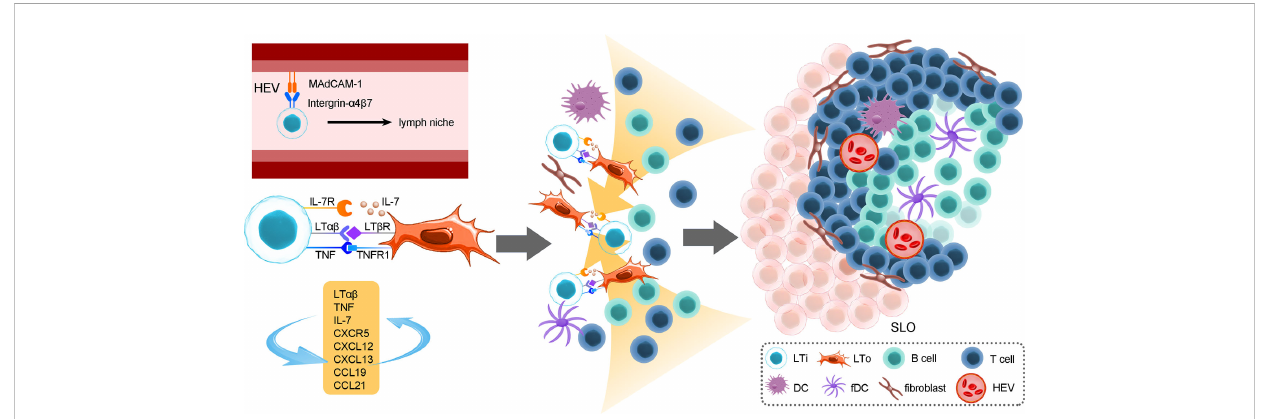
FIGURE 2 The roles of LTi cells in the development of secondary lymphoid organs. The formation of SLOs in the mouse intestine strictly depends on LTi cells. SLO development is highly reliant on the crosstalk between LTi cells and LTo cells and consequently immune cell recruitment, reticular scaffold formation and HEV or lymphoid vessel formation. In addition, positive feedback loops between LTi and LTo cells sustain suf fi cient activation signals for the development of SLOs. The location of PPs is fi xed embryonically, and their formation cannot be induced by bacteria after birth, while CP and ILF formation is more fl exible; the initiation of CPs or ILFs can occur both prenatally and postnatally. In addition, the unevenly colonized ILFs indicate that the gut microenvironment, which includes microbes and dietary metabolites, could exert a crucial role in ILF